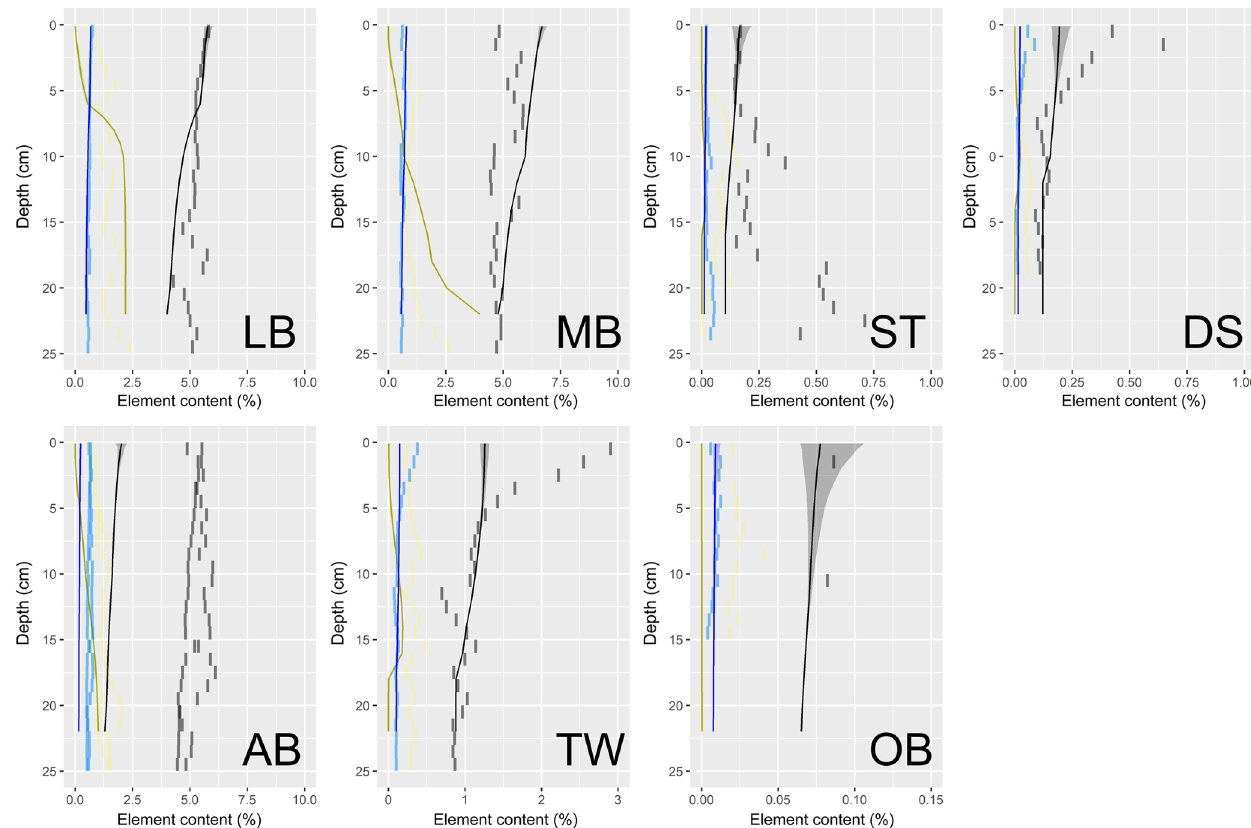
Figure 7. Mass fractions of nitrogen (blue), sulfur (yellow) and organic carbon (black) in the dry sediment: model results (curves and shading for seasonal range) versus measurements (vertical segments). Please note that the scales on the horizontal axes differ by a factor of